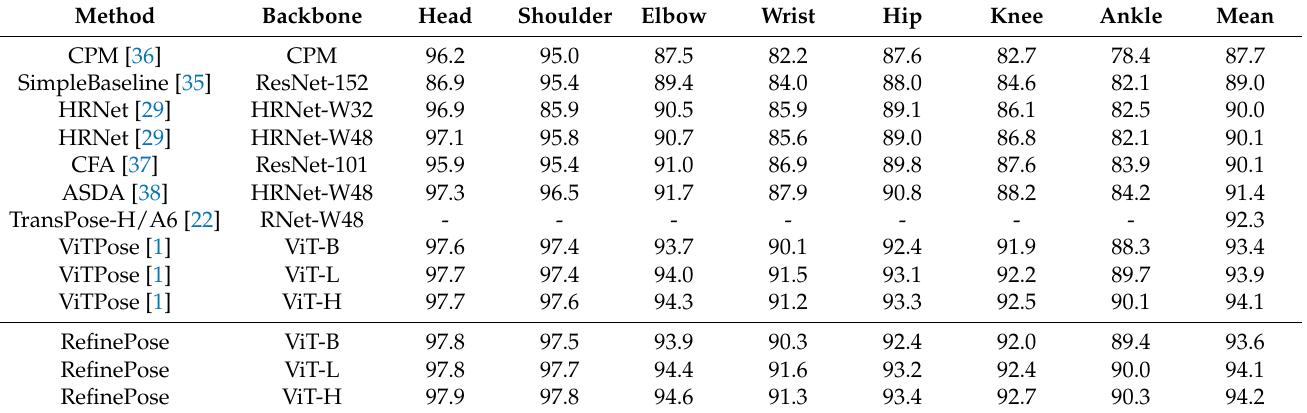
Table 2. Comparison with SOTA methods on the MPII dataset (PCKh@0.5).